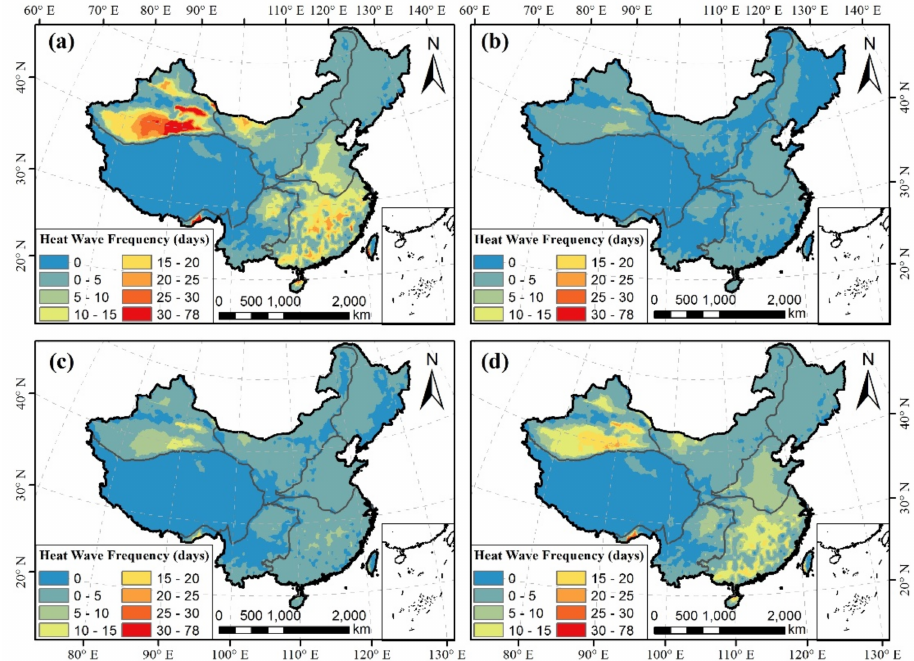
Figure 5. Spatial distribution of average annual ( a ) total heatwave frequency, ( b ) severe heatwave frequency, ( c ) moderate heatwave frequency, and ( d ) light heatwave frequency over China during 1979–2018. Total heatwave frequency is sum of severe, moderate, and light heatwave